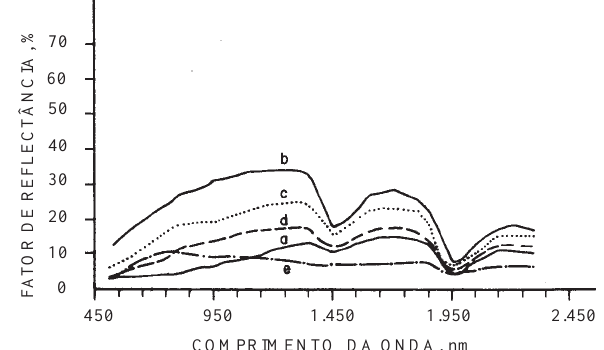
Figura 2. Curvas representativas de cinco padrões espectrais de solos minerais, segundo Stoner & Baumgardner (1981), e o respectivo comportamento espectral: (a) dominado pela matéria orgânica (representado por um solo com elevado conteúdo de matéria orgânica (1) , textura moderadamente fina); (b) minimamente alterado (baixo teor de matéria orgânica, médio teor de óxido de ferro (2) ); (c) afetado por óxidos de ferro (baixo teor de matéria orgânica e médio teor de óxido de ferro); (d) afetado por matéria orgânica (elevado teor de matéria orgânica textura moderadamente grosseira) e (e) dominado por óxidos de ferro (elevado teor de óxidos de ferro, textura